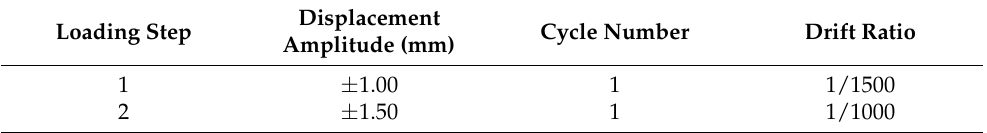
Table 5. Lateral cyclic loading